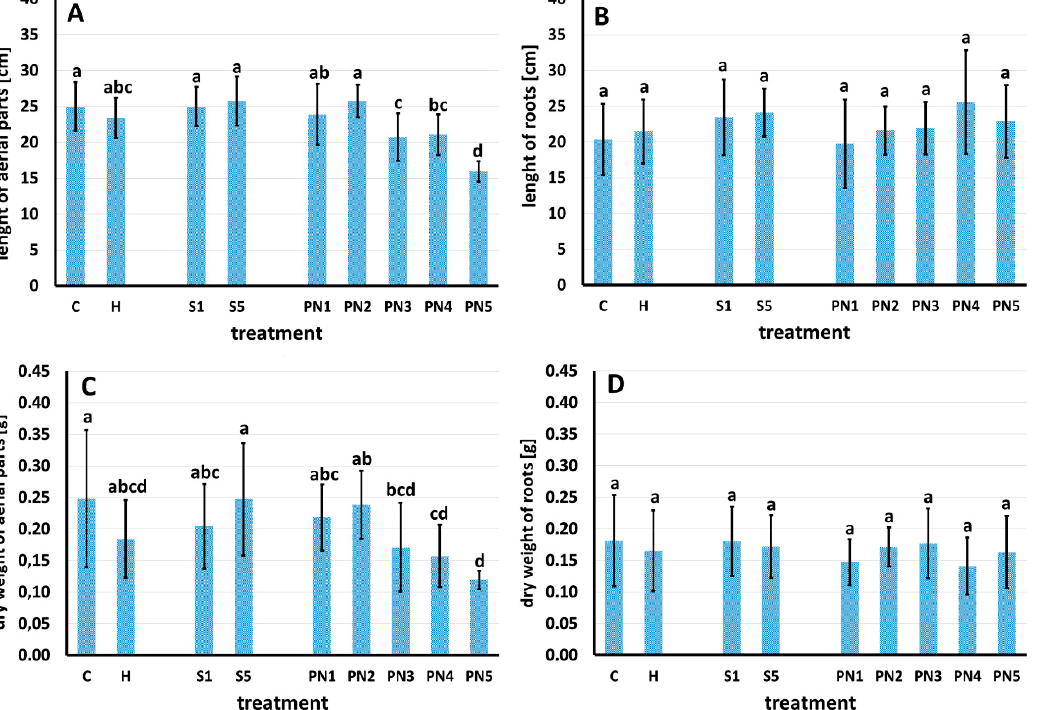
Figure 7. Length of aerial parts ( A ), length of roots ( B ), dry weight of aerial parts ( C ), and dry weight of roots ( D ) of maize seven days after spraying with water—C, herbicide—H, surfactants—S1 (1% v / v ) and S5 (10% v / v ), and nanoemulsions with peppermint oil PN1 (1% v / v ), PN2 (1.5% v / v ), PN3 (2% v / v ), PN4 (5% v / v ), and PN5 (10% v / v ). Bars represent mean value ± SD. The letters a–d indicate statistically significant differences. Values indicated by the same letters did not differ significantly at p ≤ 0.05 according to Duncan’s test (within the tested species), n = 4. The first group of maize plants, with the longest aerial parts, included control sprayed with water (C), surfactants S1 and S5 (1% and 10% v / v ), and nanoemulsion PN2 (1.5% v / v ). The second group, but non-significantly different from the first one, consisted of maize sprayed with herbicide (H) and nanoemulsion PN1 (1% v / v ). Of a significantly reduced length of the aerial parts, the third group was maize sprayed with nanoemulsions PN3 and PN4 (2% and 5% v / v ); the shortest aerial parts of maize were recorded after spraying it with the nanoemulsion PN5 (10% v / v ). The aerial parts of the maize sprayed with PN5 were 36% shorter than those of the control C (Figure 7A). The dry weight of the aerial parts of maize was generally in line with their length. The maize plants sprayed with water (C) and surfactant S5 displayed the highest dry weight of the aerial parts. The lowest weight of aerial parts was recorded for maize sprayed with PN4 and PN5; it was lower by 36–48% than the C and S5 maize. At the same time, the dry weight of maize sprayed with PN5 was similar to the dry weight of maize sprayed with herbicide (H) and PN4 and PN3 (Figure 7B). Spraying with the PNs caused significant changes in the length of barnyard grass aerial parts (Figure 8A) but not its roots (Figure 8B). Barnyard grass sprayed with water (C) and S1 had the longest aerial parts; these plants differed significantly from all the other treatments. The barnyardgrass sprayed with S5, PN1, and PN2 was the second homoge- neous group with the aerial parts significantly longer than the PN4, PN5, and H, consti- tuting the third group with the shortest aerial parts length, 36–40% shorter than the C